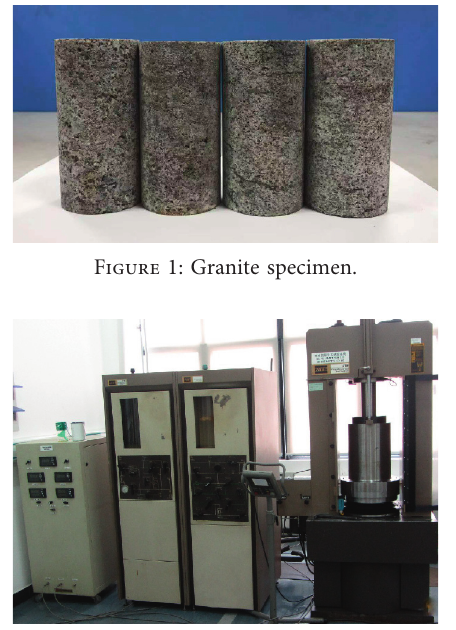
Figure 2: MTS815.02 testing system.